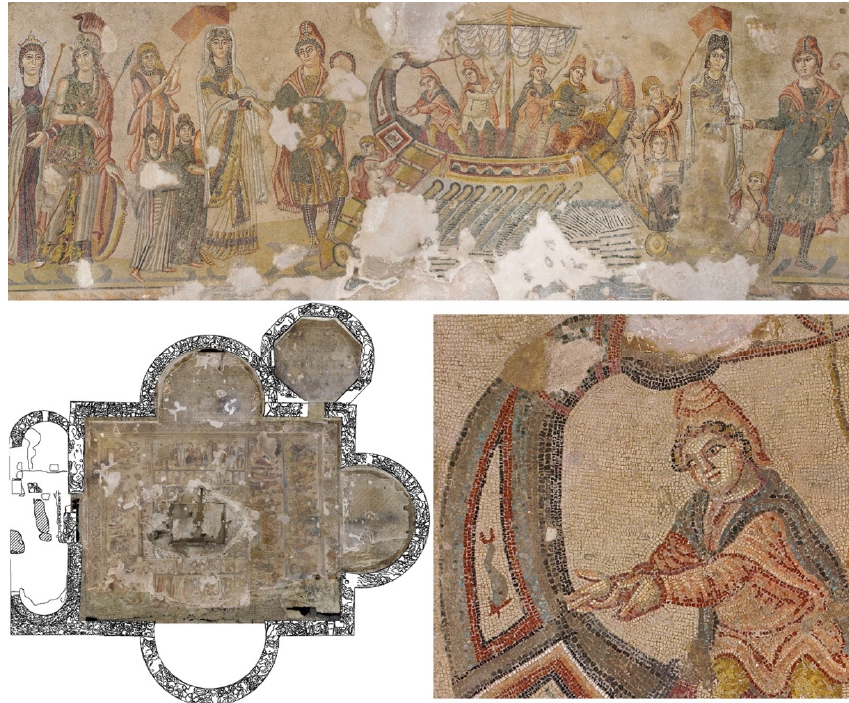
Figure 1. The floor mosaic in the triconch hall of the villa of Noheda. ( Top panel ) lower register of the mosaic in the eastern part of the triclinium, showing the abduction of Helena by Paris and her arrival at the gates of Troy (to the right of the scene); ( lower left ) orthophoto superimposed on the ground plan of the triclinium; ( lower right ) detail of one of the sailors from the ship, containing a substantial number of glass tesserae.